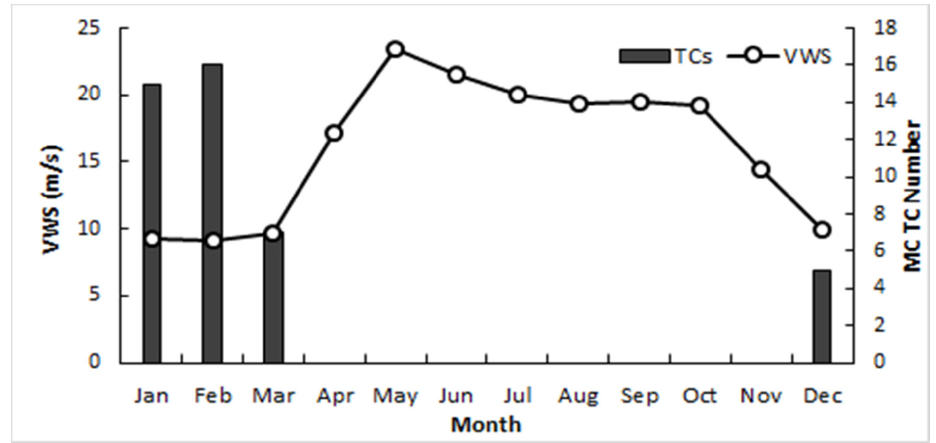
Figure 6. Monthly totals of cyclogenesis events in the MC (bars) and monthly mean VWS